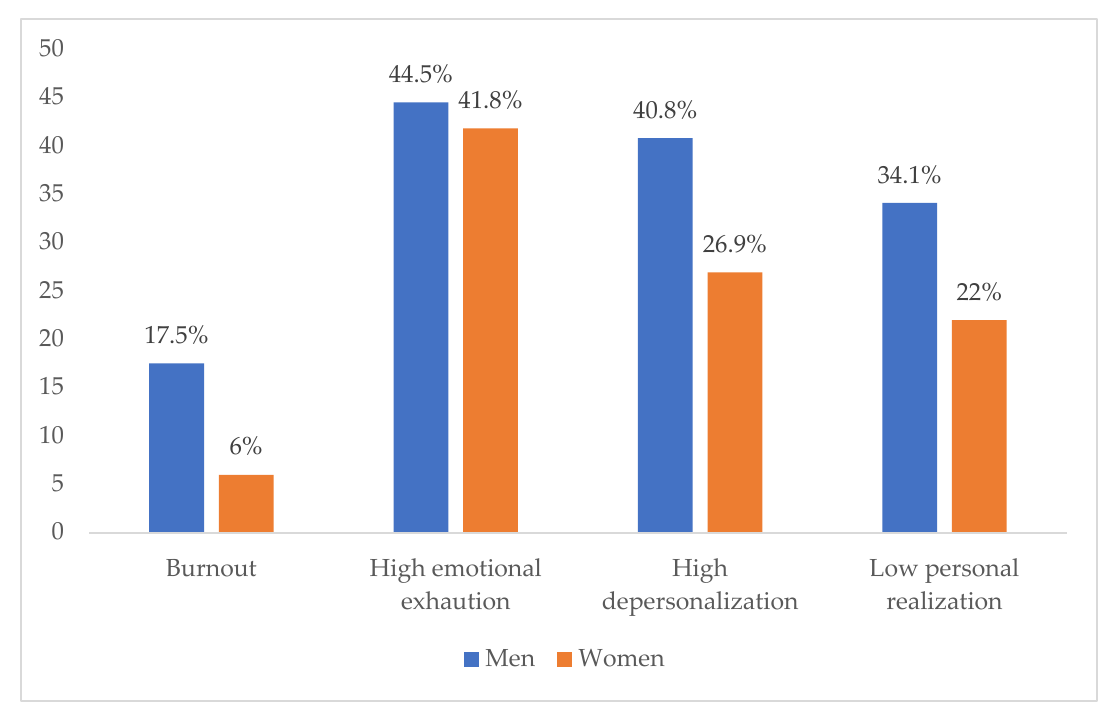
Figure 3. Correlation of burnout and its dimensions with sex .